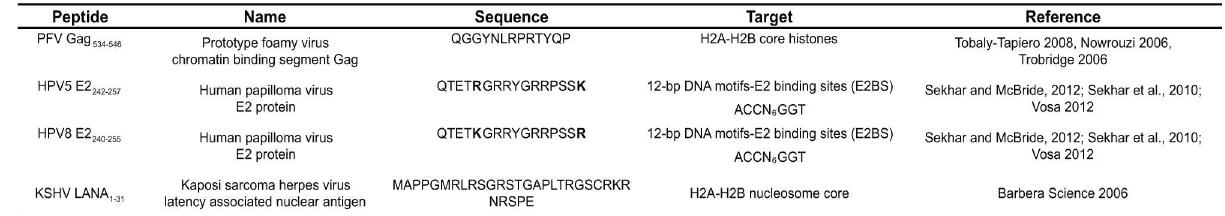
Fig 2. Peptide characteristics. Fig showingthe acronyms, aa-sequences and bindingcharacteristics of the peptides used to generate the artificial LEDGF tethers. PFV, Prototype foamy virus; HPV, Human papillomavirus; KSHV, Kaposi’s sarcoma herpes virus; LANA, Latency associated nuclear